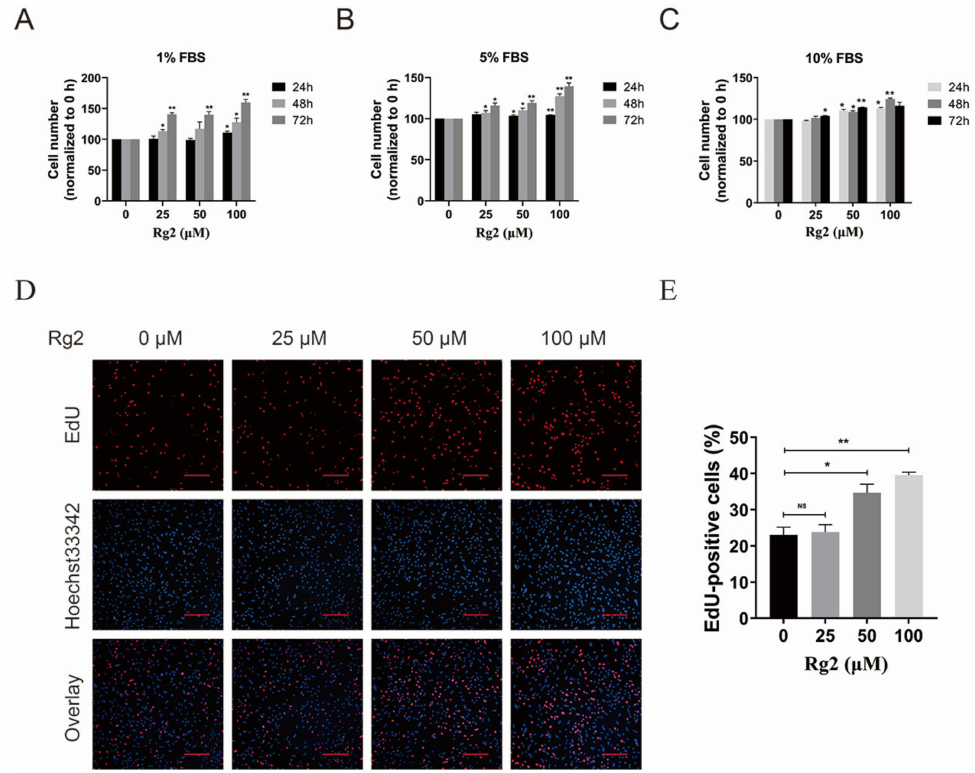
Figure 4. Ginsenoside Rg2 promoted the proliferation of pMSCs. ( A ) MTT assay of pMSCs after treatment with different concentrations of Rg2 in basic medium containing 1% FBS. ( B ) MTT assay of pMSCs after treatment with different concentrations of Rg2 in basic medium containing 5% FBS. ( C ) MTT assay of pMSCs after treatment with different concentrations of Rg2 in basic medium containing 10% FBS. ( D ) EdU staining of pMSCs after treatment with different concentrations of Rg2. Scale bar = 200 µ m. ( E ) Quantification of the EdU staining in ( D ). * p < 0.05 and ** p < 0.01; n =